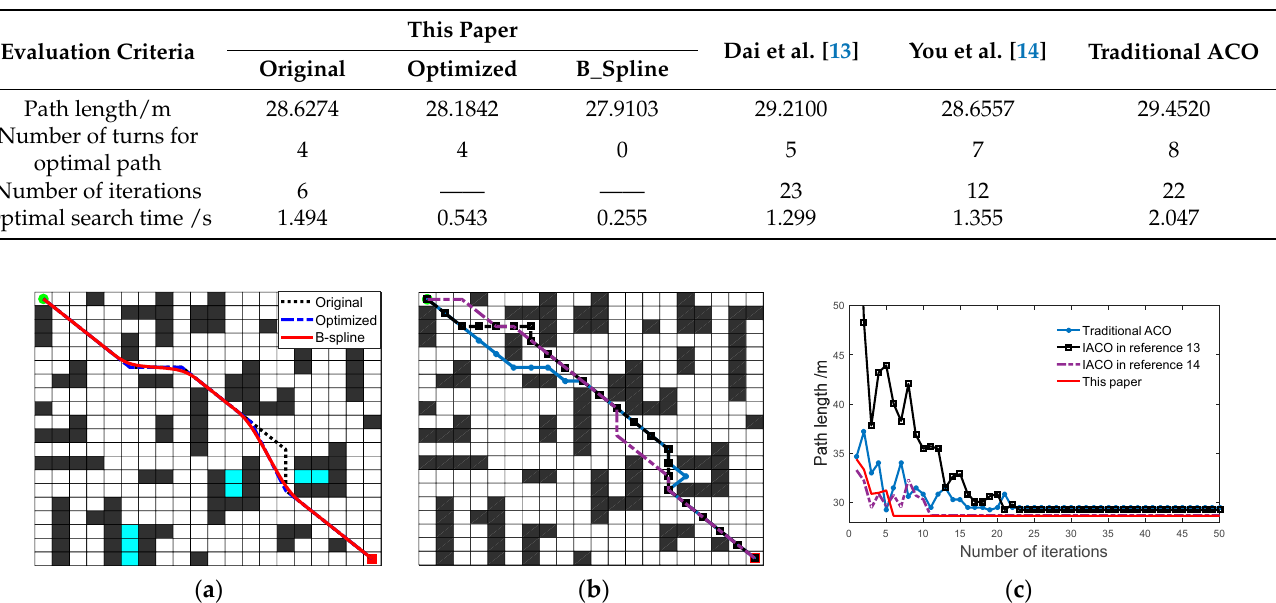
Table 5. Performance comparison table for U-shaped environment algorithms.